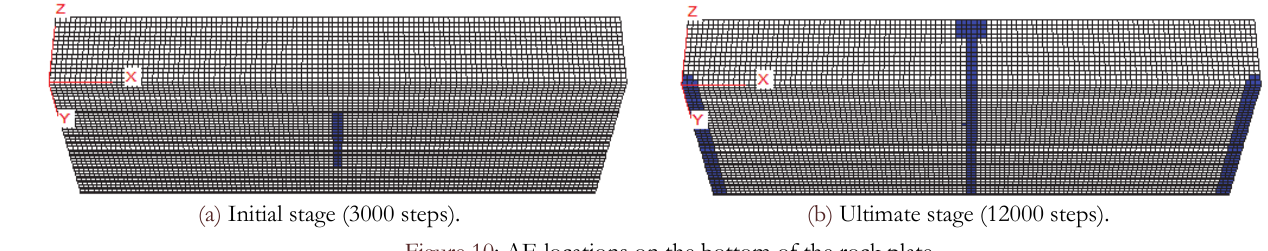
Figure 10: AE locations on the bottom of the rock plate.